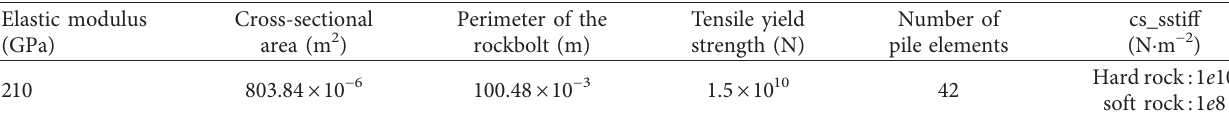
Table 3: Simulation model input parameters for pile elements.